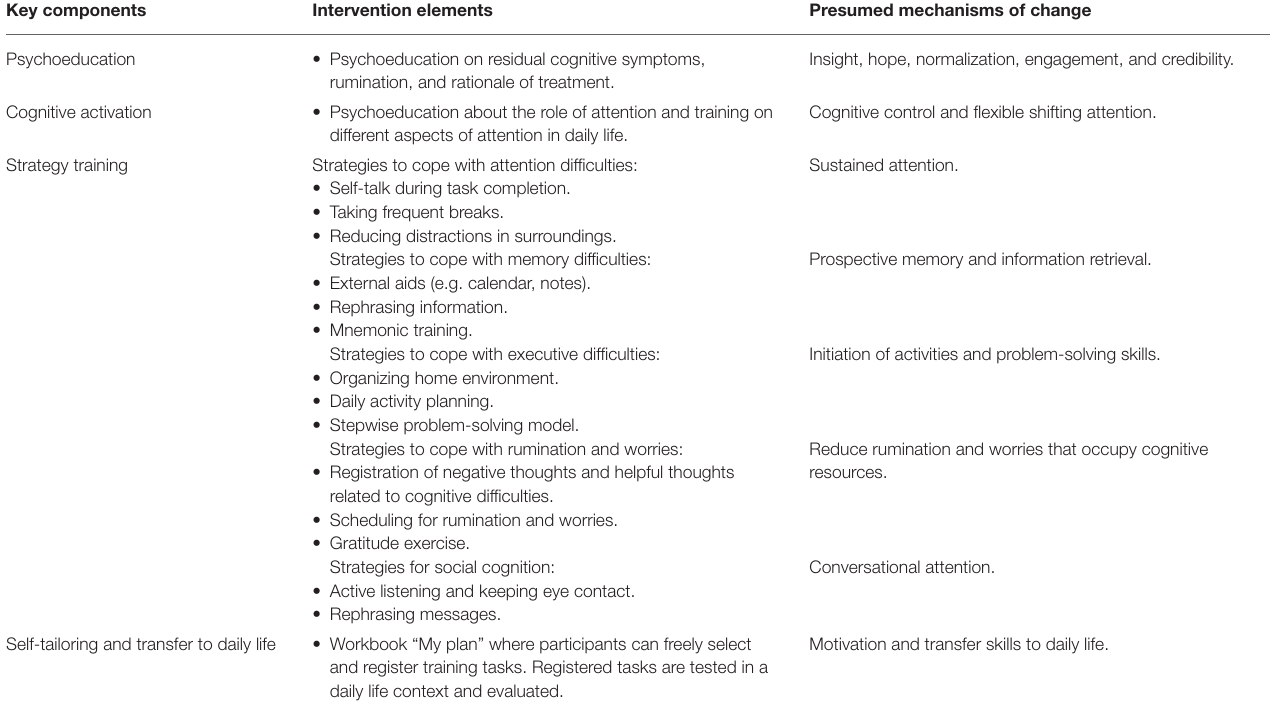
TABLE 1 | Overview of intervention key components, intervention elements, and presumed mechanisms of change. Key